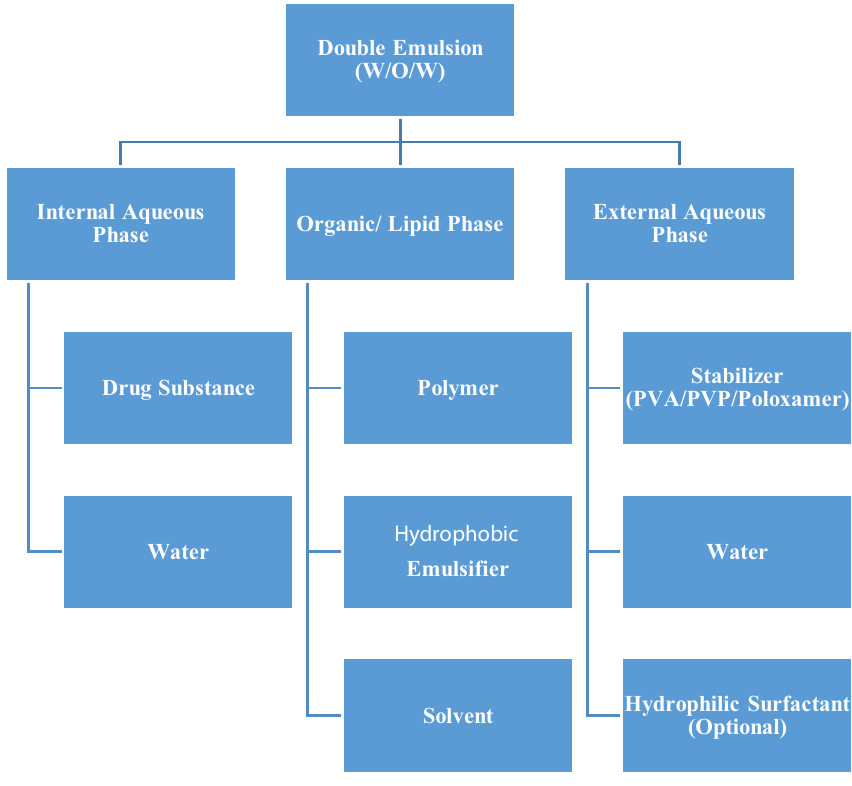
Fig. 4 Components of a dou- ble emulsion